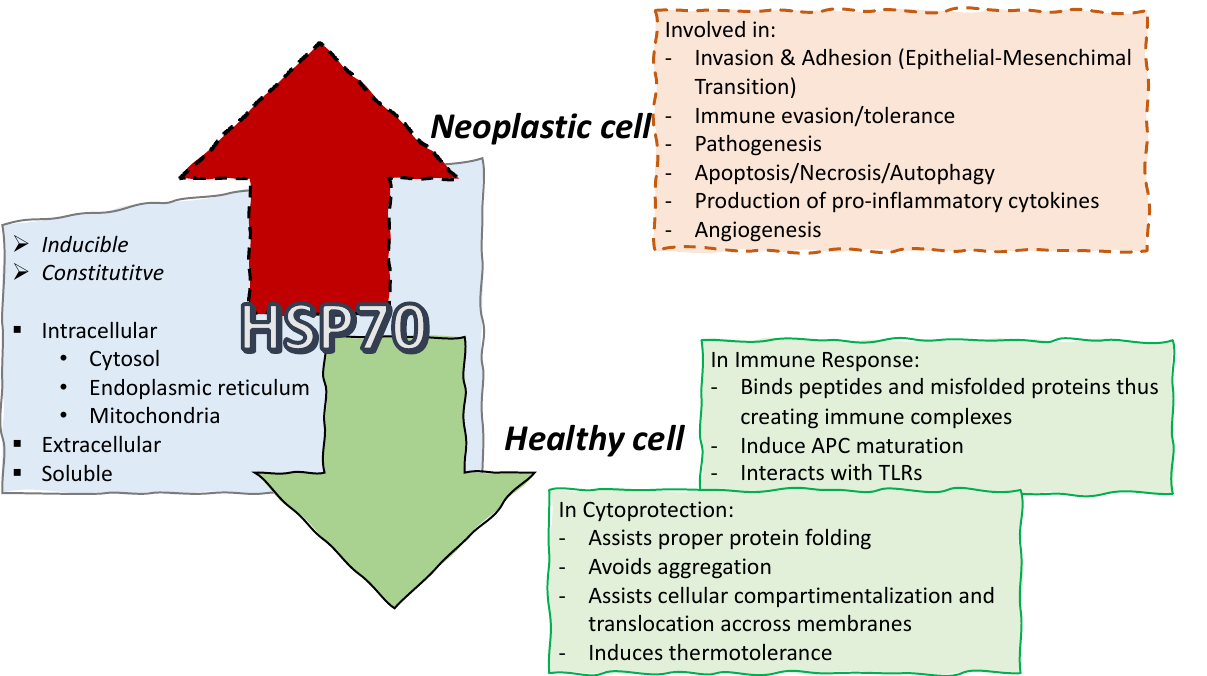
Figure 1. HSP70 involvement in healthy versus neoplastic cell. Di ff erent forms and localization of HSP70 are reported in the grey object. Roles of HSP70 are described in physiologically healthy cells, (green continuous line) and tumor conditions (cancerous cell, red do tt ed line) [11,14,16–18]. APC = antigen presenting cell; TLRs = toll like receptors.